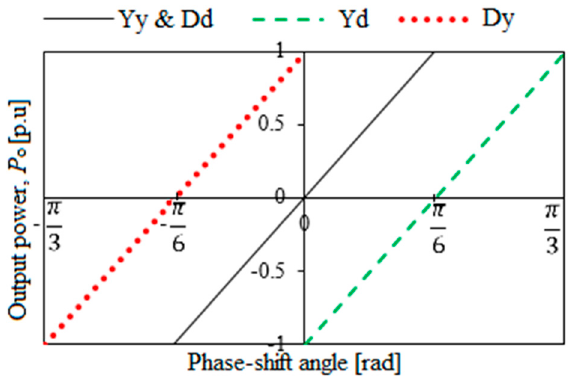
Figure 8. Phase-shift angle versus output power curve of the 3P-BIDC with different transformer configurations.